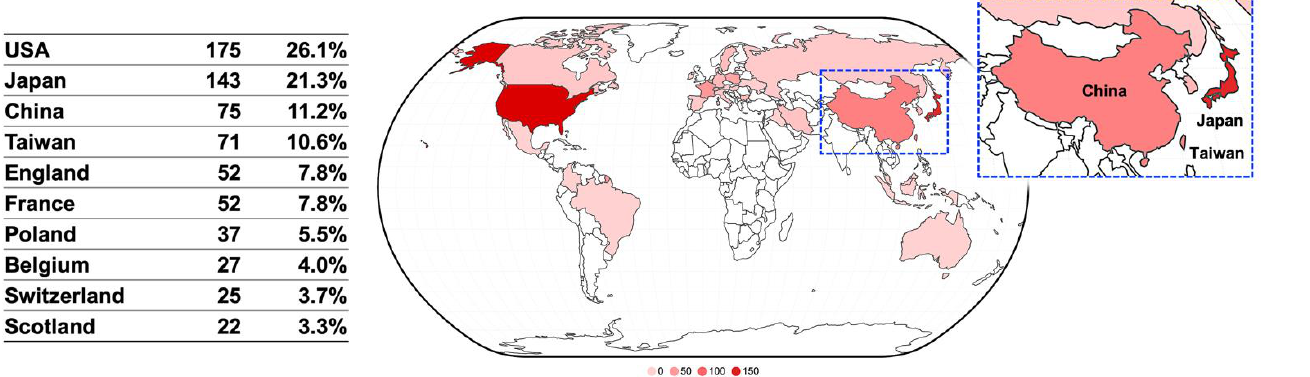
Figure 3. The top 10 countries contributing the most to the area of PCSEL and the corresponding world choropleth map for the relevant publications retrieved from Clarivate Analytics’ Web of Sci- ence (WoS) bibliometric database. Inset: A zoom-in view of Taiwan (blue dashed line square), whose population base is far less than the other highly ranked, has the competitive potential in the PCSEL research area.